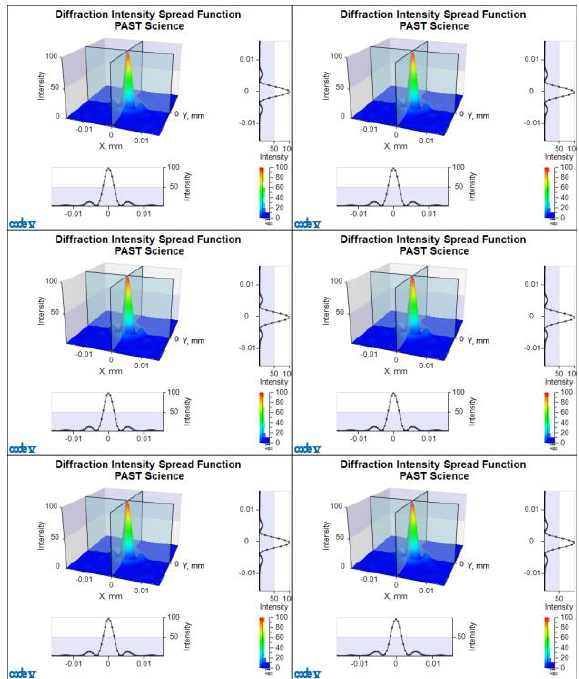
Figure 4 The system point spread function